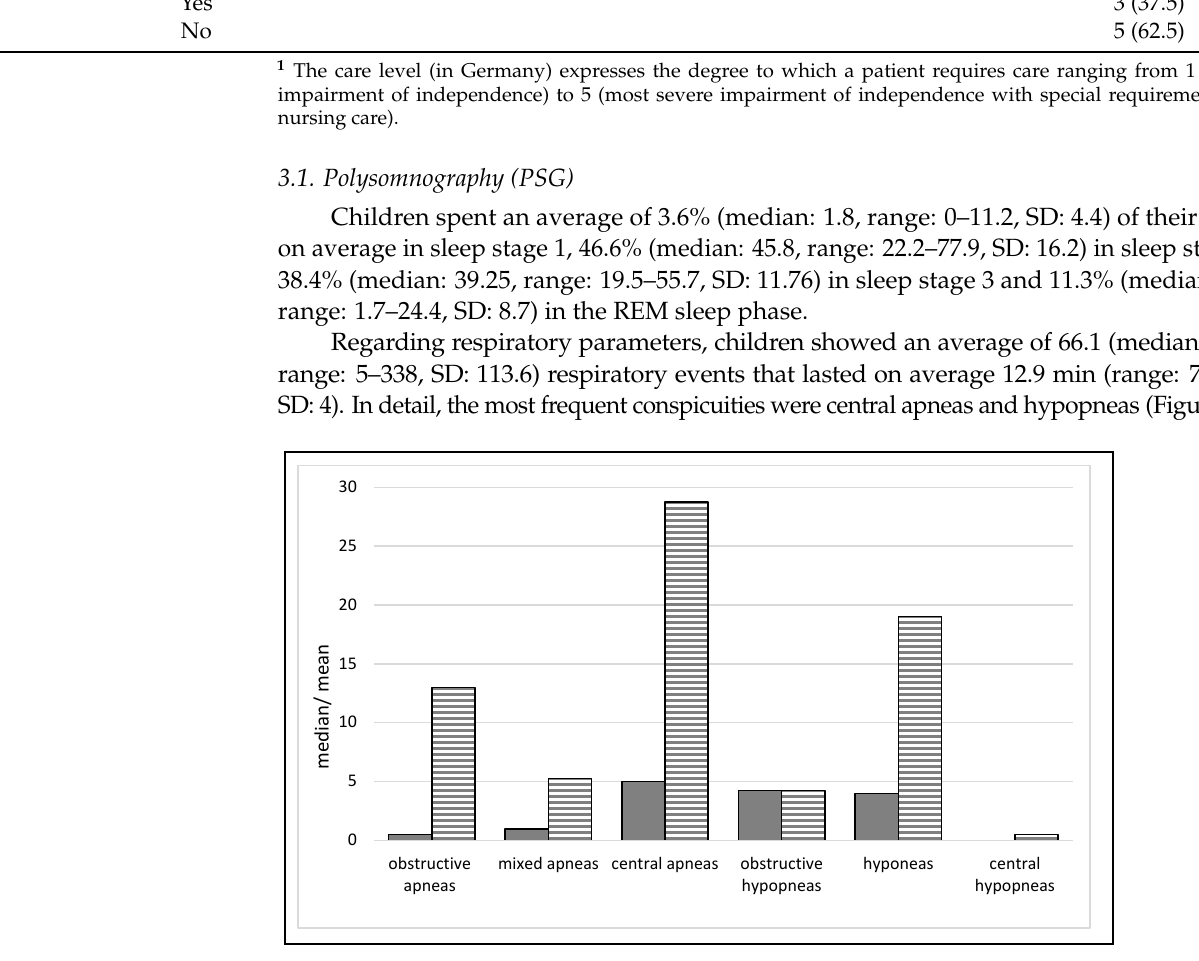
Figure 1. Median and mean (striped) frequency of respiratory events were assessed during the polysomnography (PSG) data collection night.